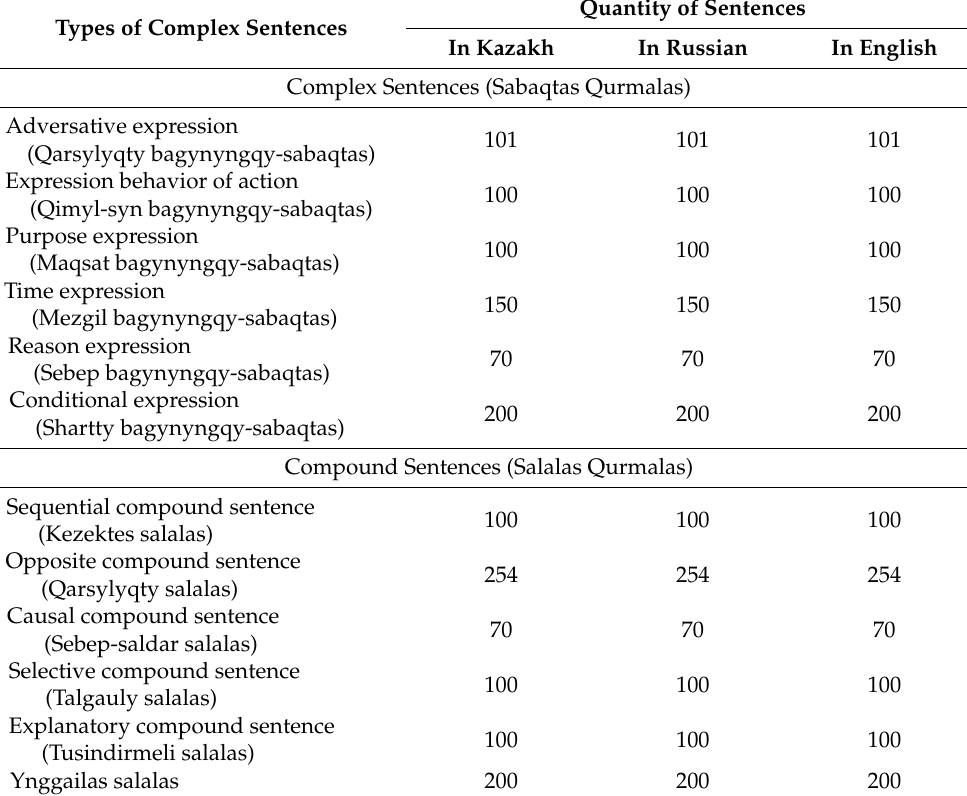
Table 1. Quantitative data of the corpus of complex sentences. Types of Complex